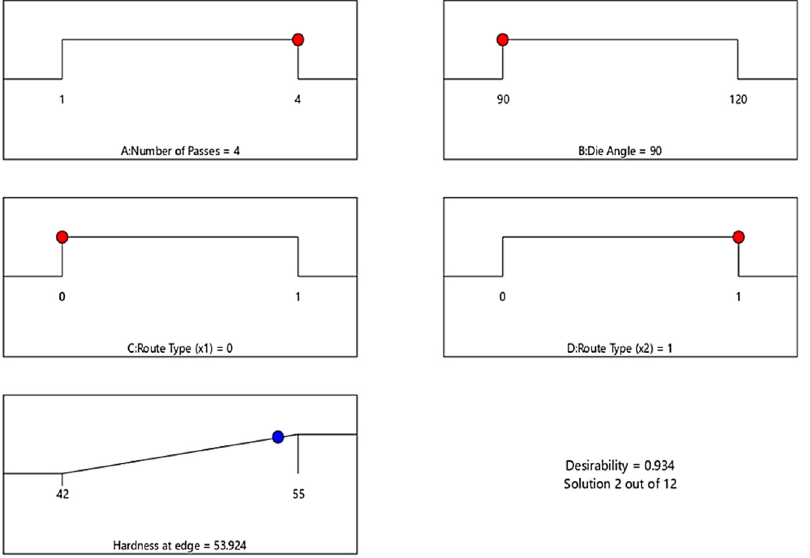
Figure 13. Optimal ECAP process parameter of H E . Red dots: ECAP condition. Blue dots: ECAP responce.